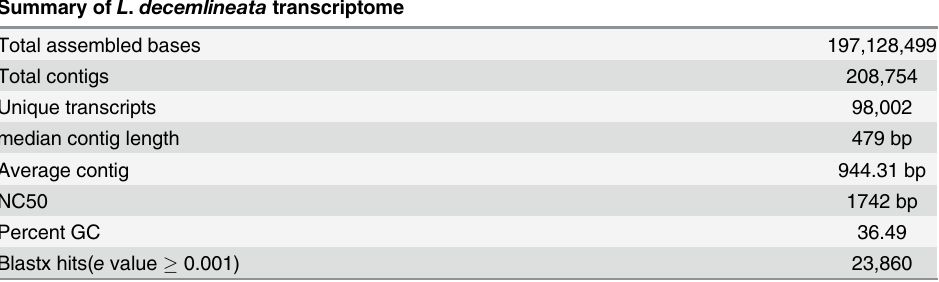
Table 3. Summary of Leptinotarsa decemlineata transcriptome assembled from the 2013 beetle pop- ulations collected from the Arlington Agricultural Research Station and two field populations, termed systemic-1 and